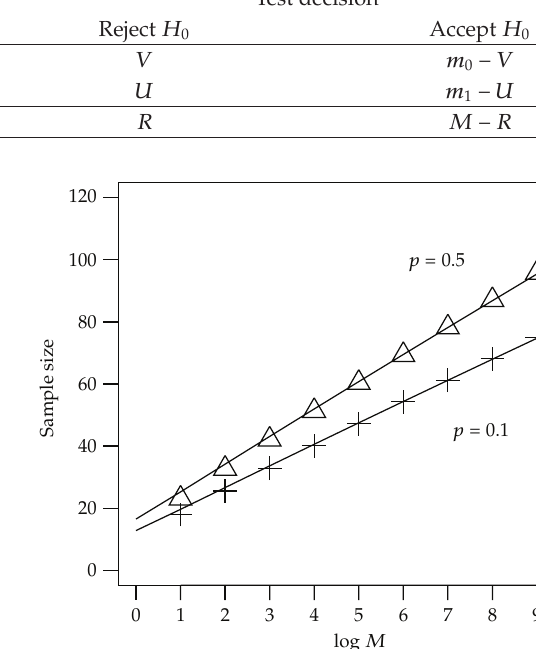
Figure 3: Number of families needed versus log M (cid:5) base 10 (cid:6) . Sample size for the TDT in the example of Risch and Merikangas (cid:3) 16 (cid:4) , with disease frequencies of 0.1 (cid:5) plus signs (cid:6) and 0.5 (cid:5) open triangles (cid:6)